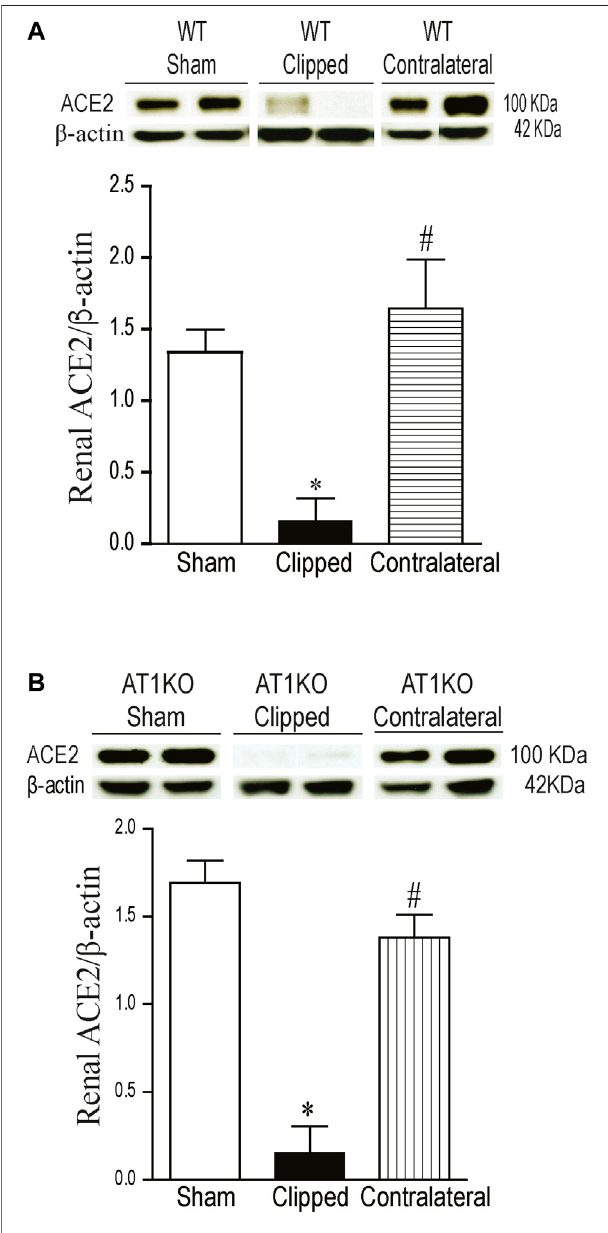
FIGURE 3 | Effect of renovascular hypertension on renal ACE2 expression in WT and AT1KO mice after 2 weeks of 2K1C Goldblatt surgery. (A) Renal ACE2 protein expression in WT sham, clipped and contralateral kidney. (B) Renal ACE2 protein expression in AT1KO sham, clipped and contralateral kidney. In each individual experiment, samples were loaded randomly in four gels and processed at the same time. Two Immunoreactive bands corresponding to immunoreactive ACE2 from each experiment were appropriately cropped and spliced as a representative of the result. One-way ANOVA showed a signi fi cant decreased in renal ACE2 expression in WT and AT1KO clipped kidneys compared to sham and contralateral kidneys (* p < 0.001 vs. sham, # p < 0.001 vs. clipped). Data are represented as mean ± SEM, (n (cid:2) 6).